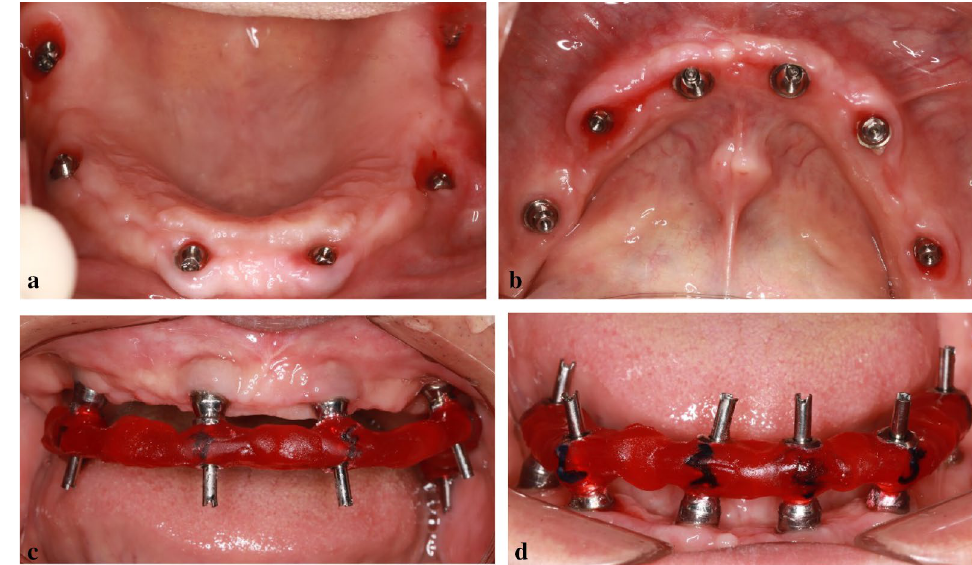
Fig. 4 A B Multi-abutments were placed. C D Transfer coping were